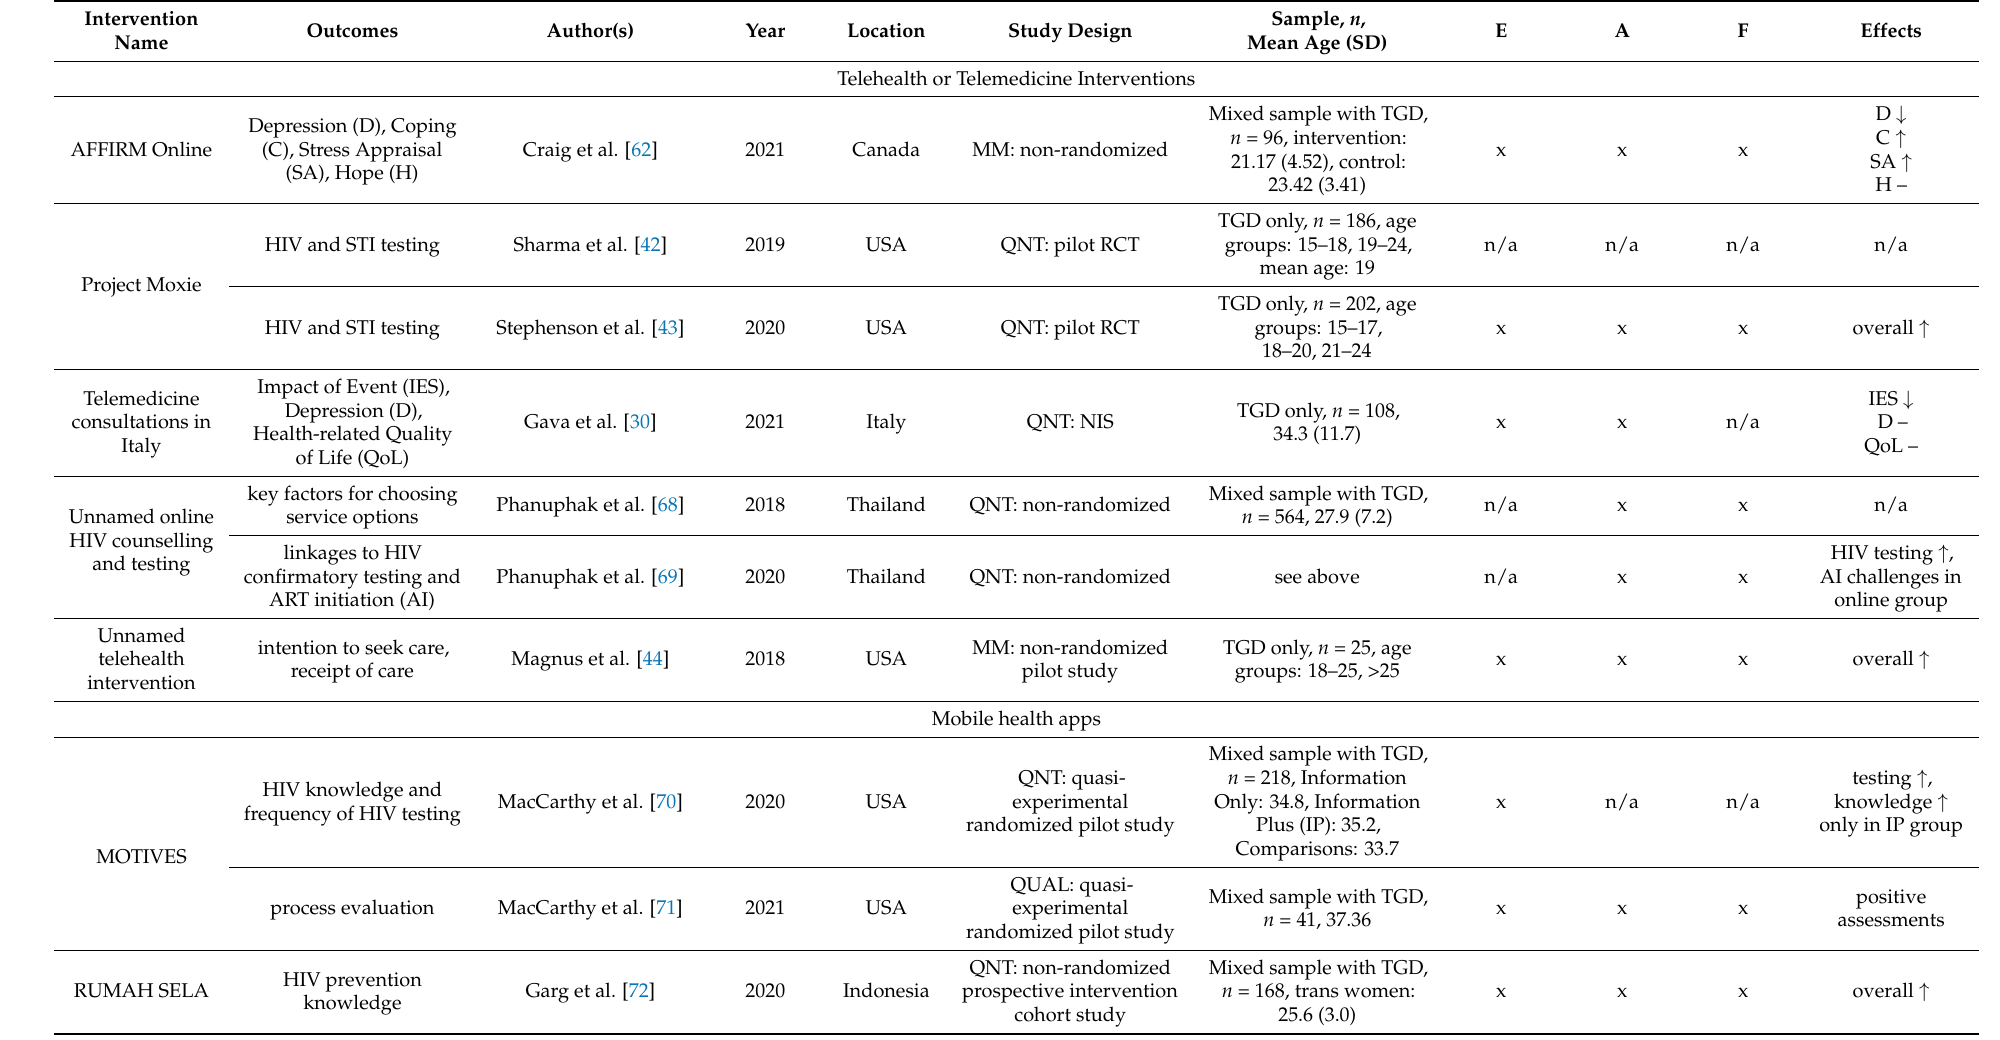
Table 2. Summary of e-health services on transgender and gender diverse health